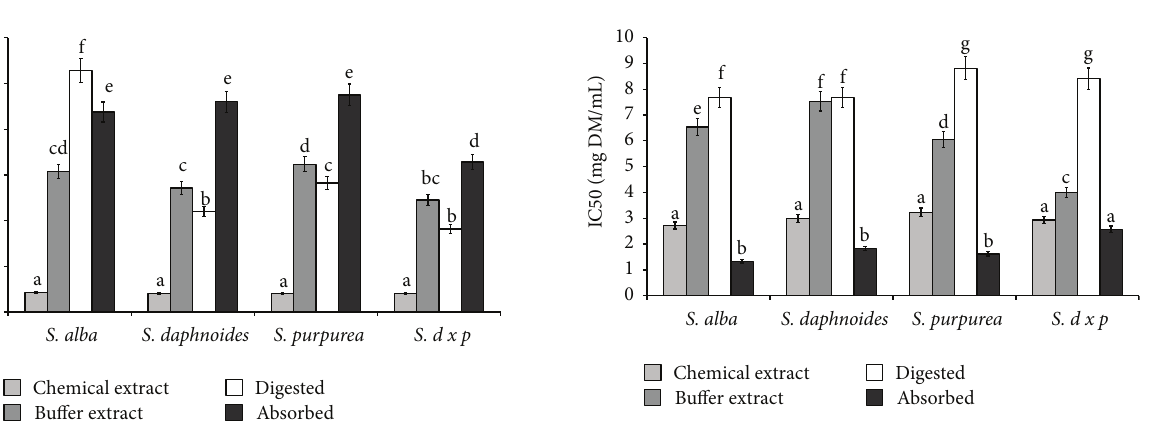
Figure 5: Effect of extraction system on LOX-inhibitory activity of phytochemicals from bark of different Salix genotype. Bars (means) followed by the different letters differ significantly (Tukey-test, 𝑃 < 0.05 ).